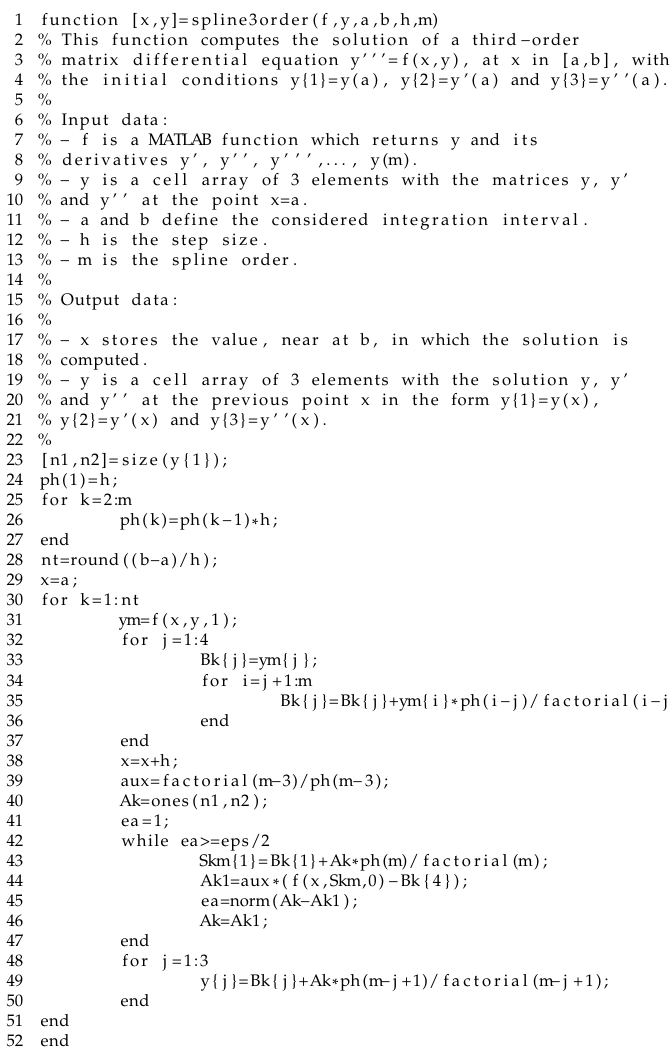
Figure 1. MATLAB code for computing approximate solutions by means of m -th order splines.